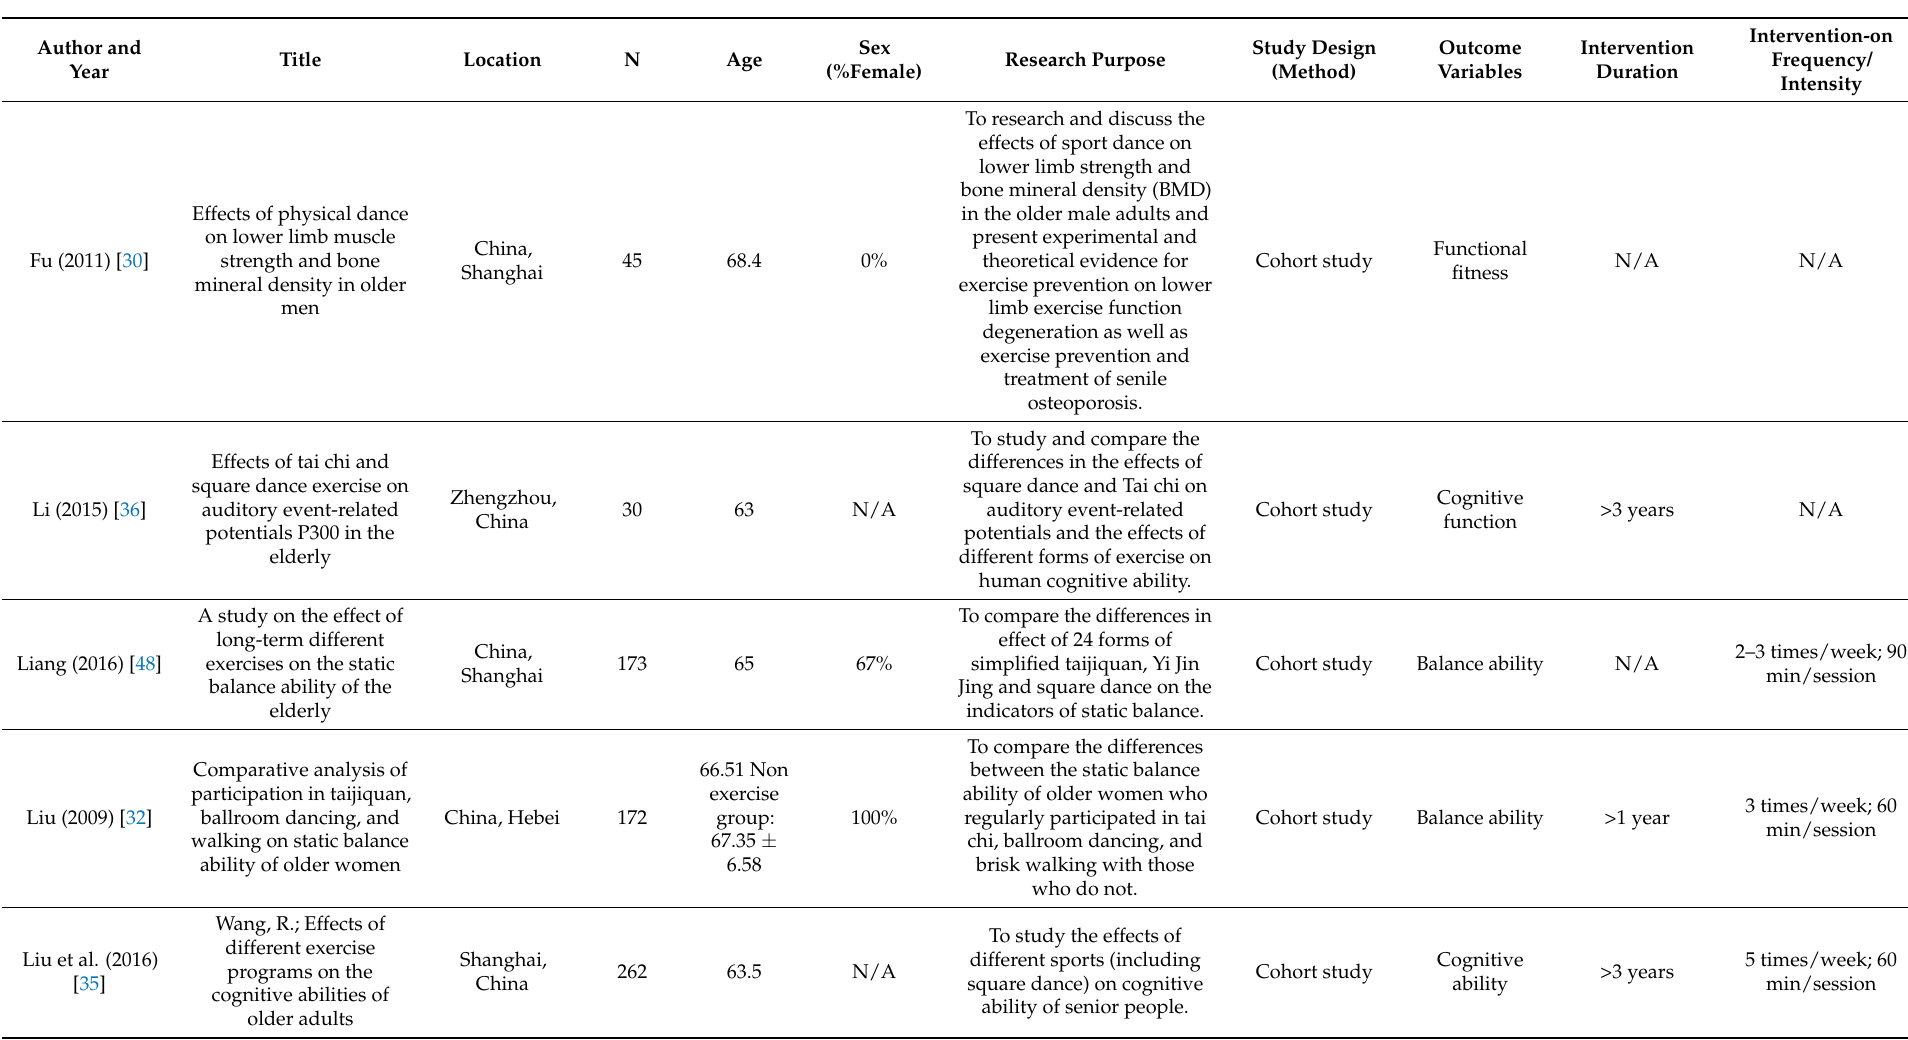
Table 2. Summary of the cohort